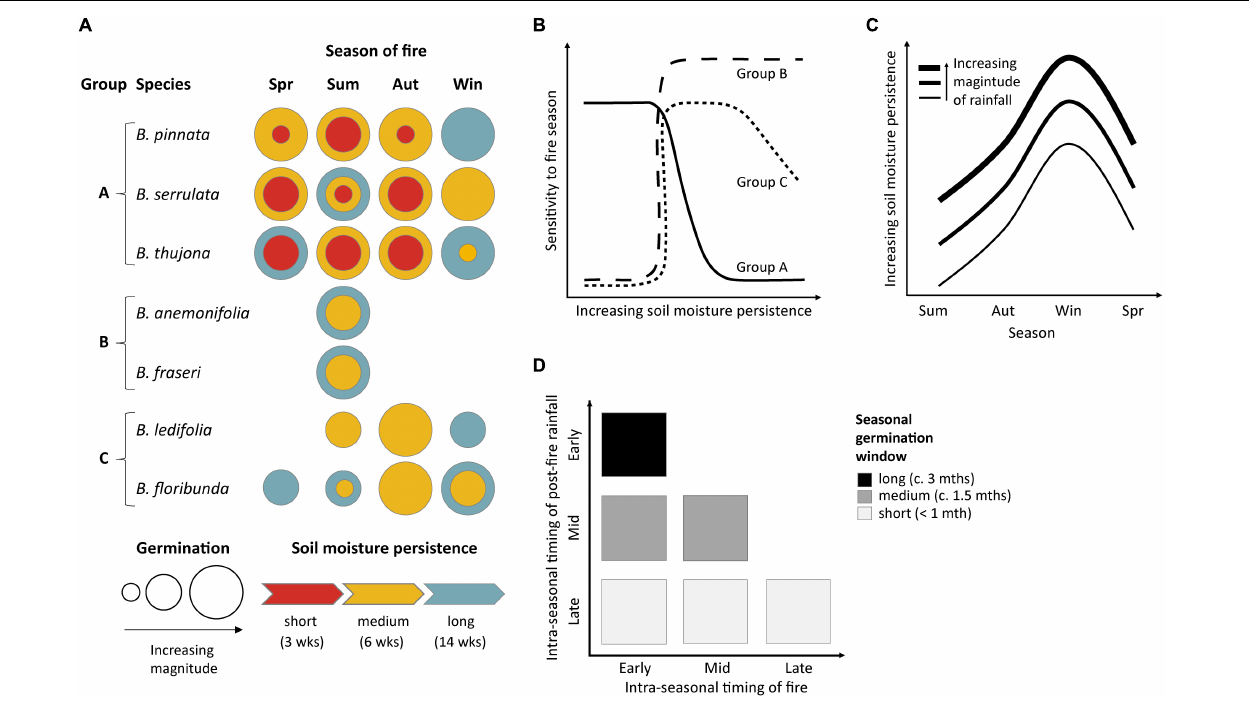
FIGURE 6 | Conceptual models of how the seasonal timing of fire and soil moisture availability affect germination of seven species of Boronia (Rutaceae) from south-eastern Australia. (A) Functional response groups defined by predicted effects of fire seasonality and soil moisture persistence on germination timing and magnitude. Spr, spring; Sum, summer; Aut, autumn; Win, winter; blank spaces – no germination response with 14 weeks. Where longer durations did not increase germination only the color for the shorter duration is presented. (B) Sensitivity to fire seasonality as a function of soil moisture persistence for the response groups identified in (A) . (C) Seasonal variation in the availability of soil moisture for germination and the effect of rainfall magnitude. Soil moisture persistence increases with greater precipitation (different curves) and is inversely related to evapotranspiration which increases in warmer months ( Supplementary Material 3 ). (D) Influence of within-season timing of fire and subsequent rainfall on the relative length of the germination window in the season of fire